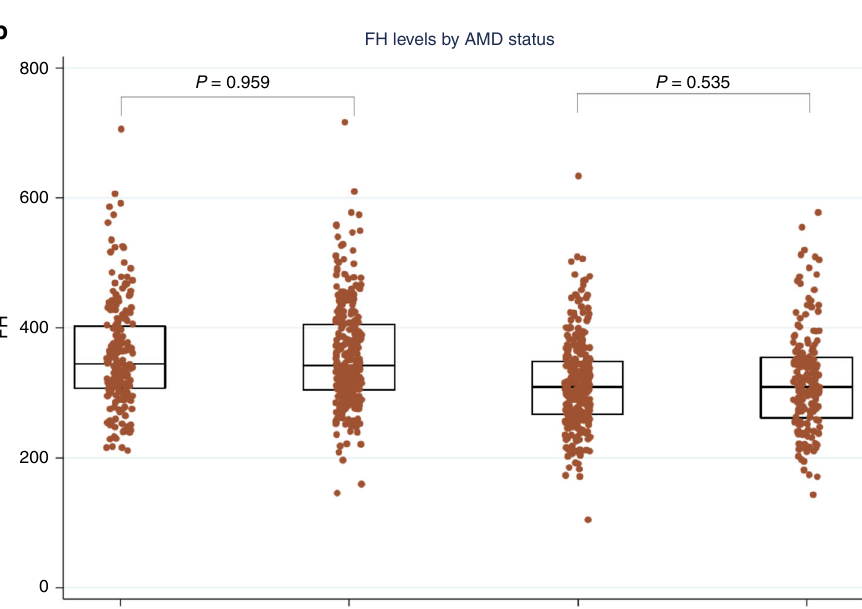
Wald test, at the top variant rs74696321). Notably, the intronic AMD risk variant rs6685931 in CFHR4 (LD with rs10922109: R 2 = 0.43, D ′ = 0.96), associated with complement activation in the recent GWAS 39 , was strongly associated with levels of FHR-4 ( β = 0.28, P value = 2.3 × 10 − 25 , Wald test), but not FH ( β = 0.005, P value = 0.607, Wald test).